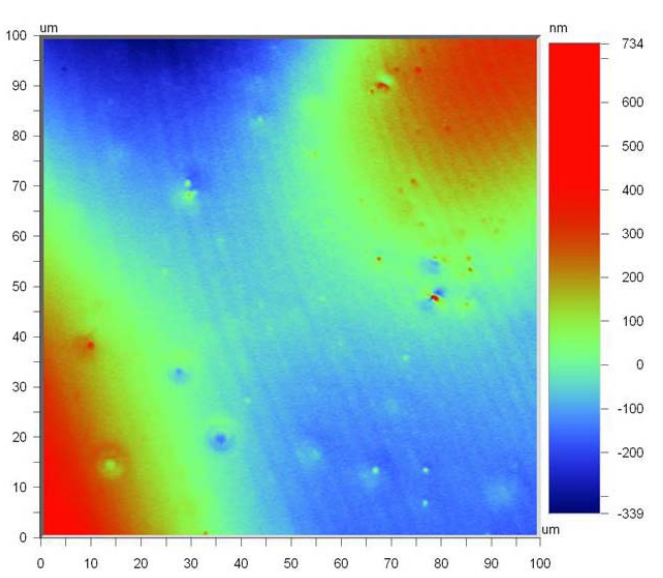
Figure 6. Surface roughness of thin film SiCN